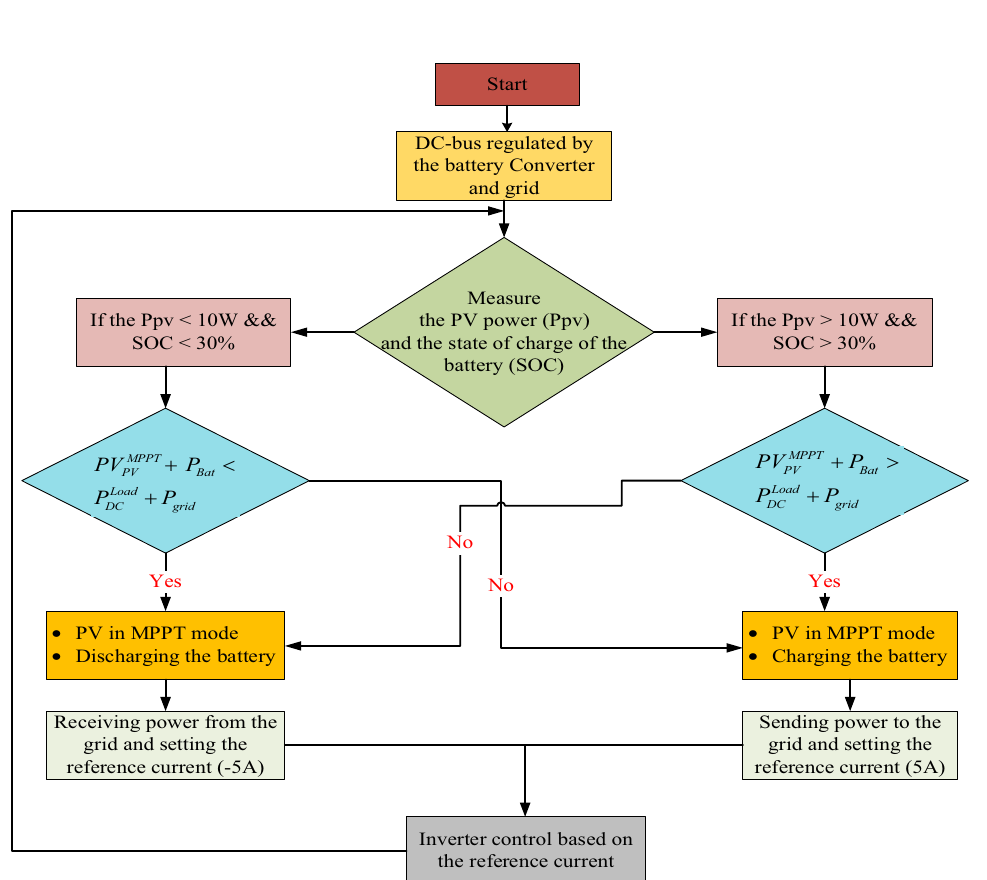
Figure 9. Flowchart of decision logic based control scheme for grid-connected